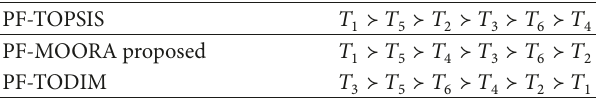
Table 17: Comparison of rank for each alternative.